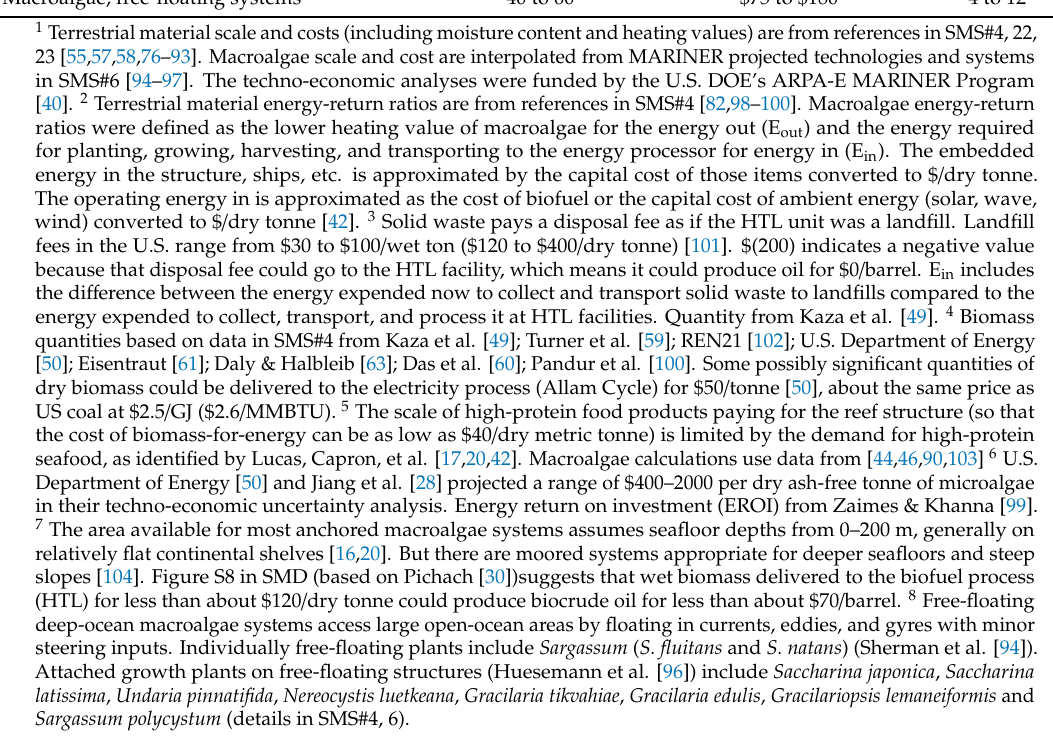
Table 3. Estimated global biomass production possibilities for some biomass sources (from SMS#3). Metric Organic waste including mixed biosolids, paper, plastic, food waste, etc. 3